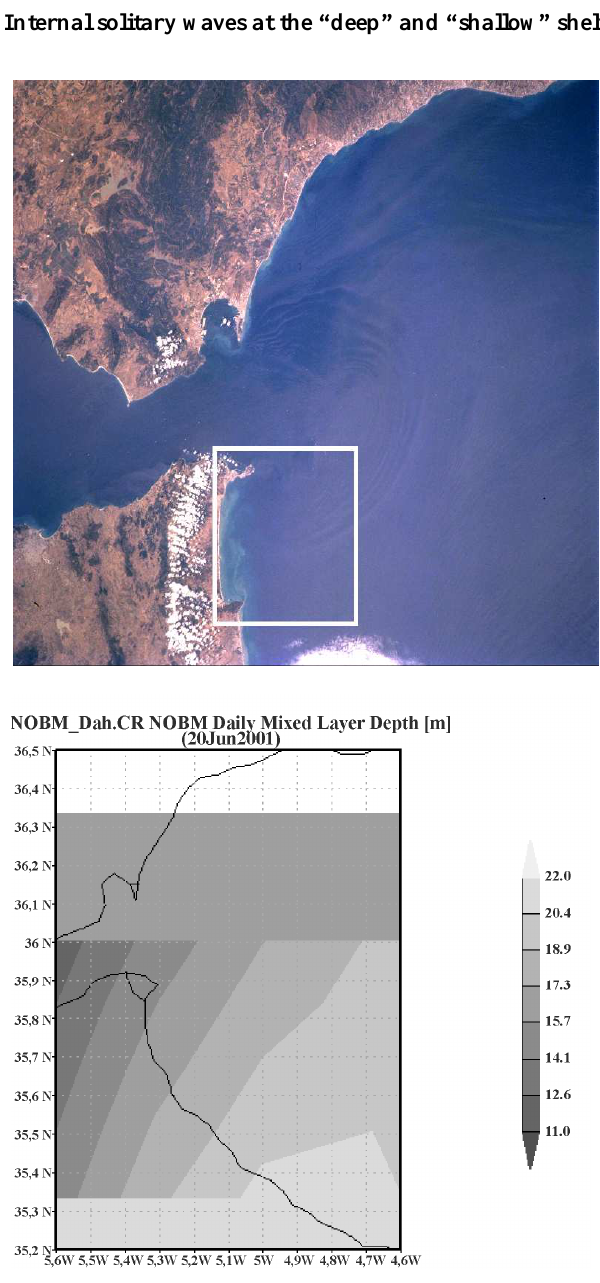
Fig. 8. Free surface manifestation of internal solitons in the Albo- ran Sea: (NASA photo ISS002-351-23 (adapted to the land relief), mission dates from 20 April to 4 May 2001 (no date for the photo). Figure 8. Free surface manifestation of internal solitons in the Alboran Sea: (NASA photo 2 At the panel below the day-averaged mixed layer depth is shown for 24 April 2001 (corresponding date was defined with the method ISS002-351-23 (adapted to the land relief), mission dates 20 April to 4 May 2001 (no date for 3 described in Appendix A). the photo). At the panel below the day-averaged mixed layer depth is shown for 24 April 4 2001 (corresponding date was defined with the method described in Appendix). 5